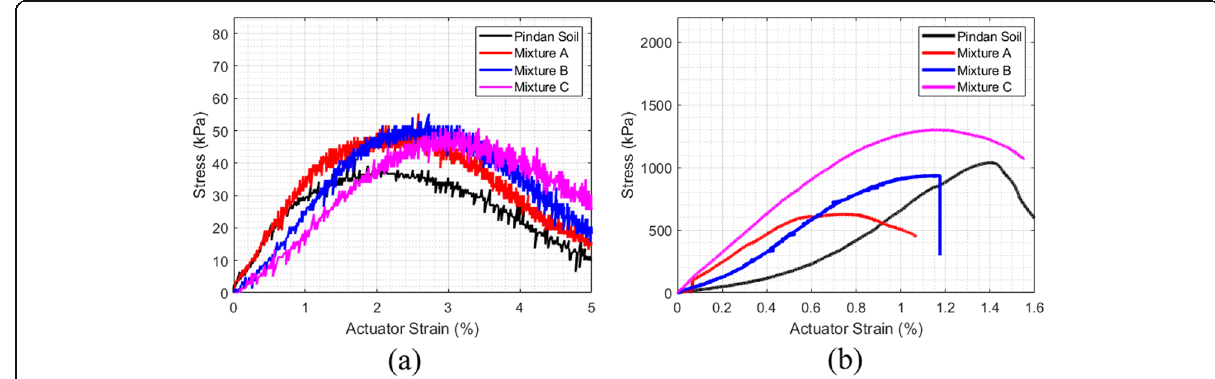
Fig. 6 Typical Unconfined Compressive Strength Curves of the compacted samples. a 1-h cured samples, b 16 days cured